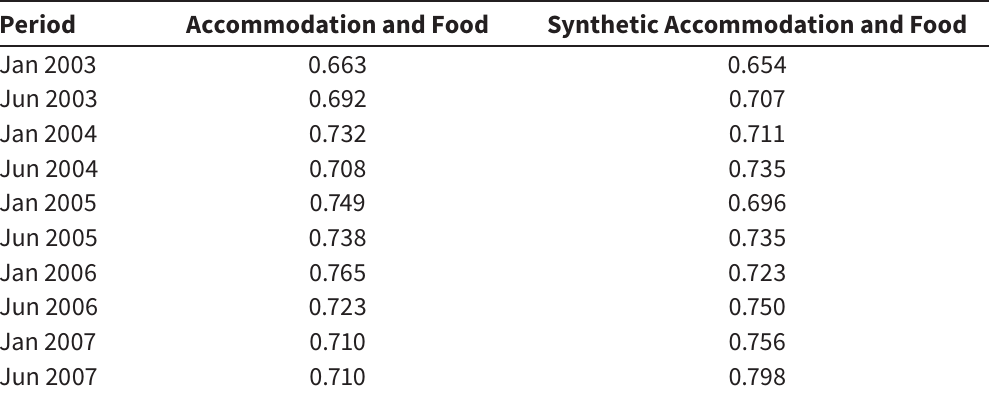
Pre-Treatment Log Employment/Population Ratio in Actual and Synthetic Accommodation and Food Industry (USA Donors) Period Accommodation and Food Synthetic Accommodation and Food